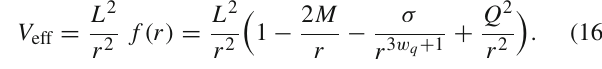
Figure 1, which is a plot of the parabola y = 1 − 2 Mu + Q 2 u 2 and the curve y = σ u 3 w q + 1 , shows the existence of three distinct horizons for Q 2 / M 2 ≤ 1 and Q 2 / M 2 > 1. In